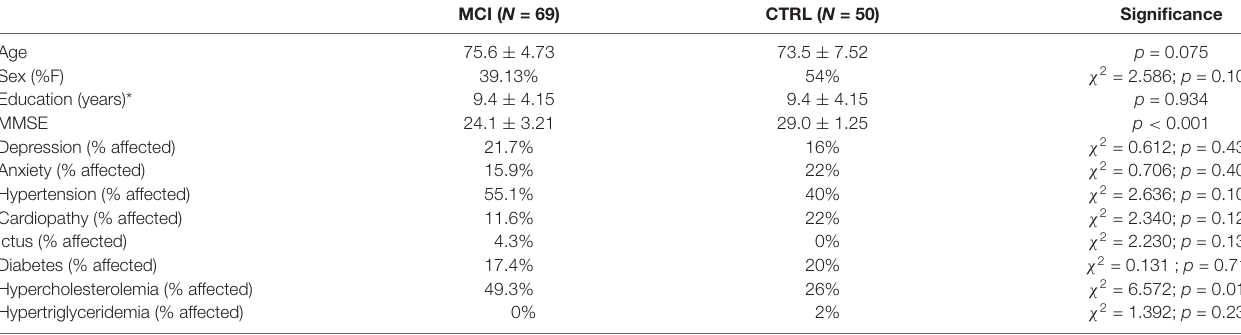
TABLE 1 | Demographic and clinical characteristics of the individuals included in the study.